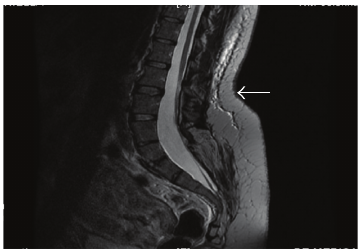
Figure 1: Sagittal view of the patient’s MRI scan with spinal cord. The arrow approximately indicates puncture site.